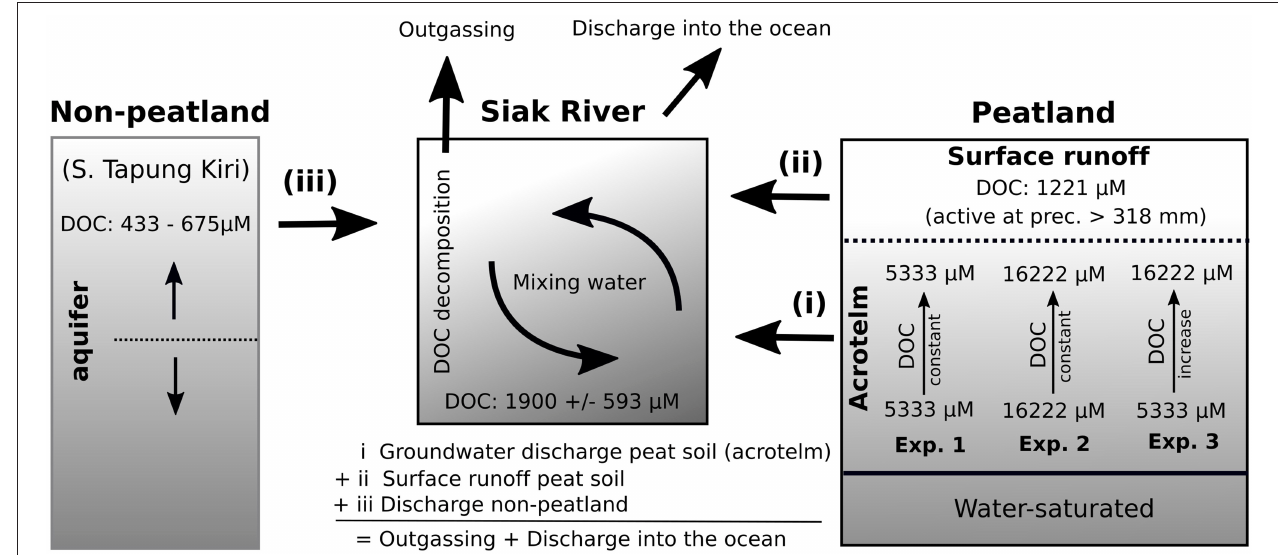
FIGURE 2 | Schematic of the model structure with the three water types (i, ii, and iii) that mix within the Siak. The source waters originate from the non-peatlands, which are to a large extent drained by the S. Tapung Kiri (See Figure 1 ), and from the peatlands. In peatlands it was further distinguished between surface runoff and groundwater discharge from the acrotelm. Groundwater DOC concentrations were varied during the three experiments. Based on our observations the DOC concentration of the surface runoff was set to 1221 µ M and those in S. Tapung Kiri tended to increase from 433 to 675 µ M with increasing precipitation rates (Table S3 and Figure S1). DOC decomposition and outgassing in addition to DOC discharges into the ocean balance DOC inputs along with the source waters. More detailed information is given in the Supplementary Material.